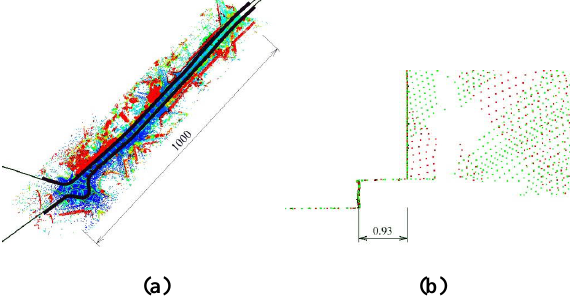
Figure 15 . MLS results: (a) top view with a search zone for tie points; (b) cross-section of a building wall.